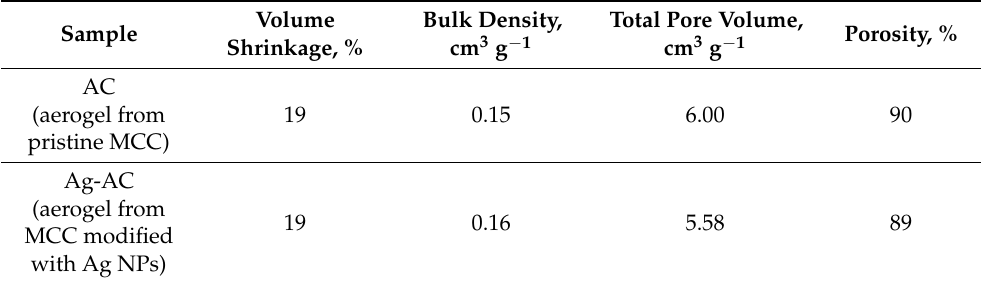
Table 1. Main characteristics of the prepared cellulose aerogels. The error for calculated values lies in the range of 5–10%.